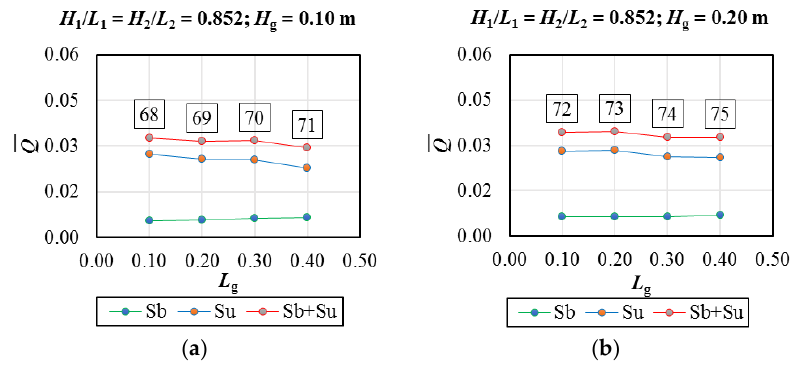
Figure 26. Behavior of Q ̅ x L g for: ( a ) cases 68, 69, 70 and 71 and ( b ) 72, 73, 74 and 75.